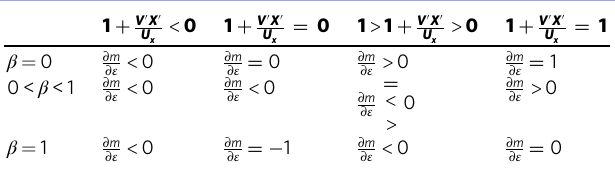
Table 1 The relationship between m and ε .